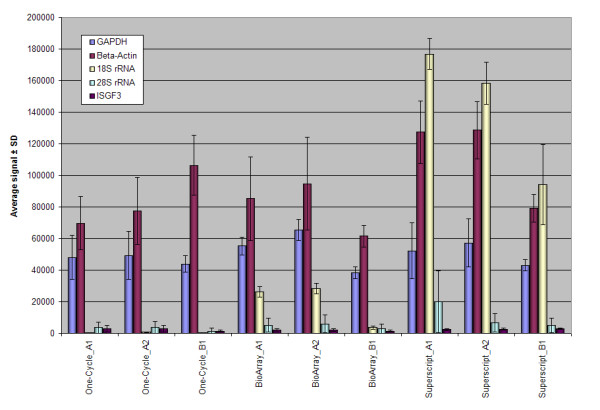
Bar chart showing averaged signal intensities for all internal control probesets (QC2) with corresponding standard deviations.